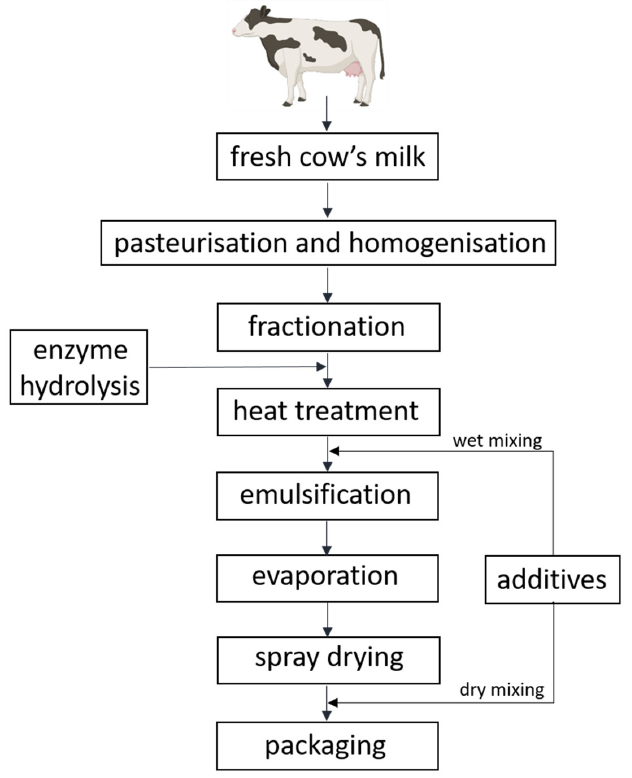
Figure 2. Example of main steps involved in the manufacturing of powdered infant formula. Fresh cow’s milk is at first standardised by means of pasteurisation and homogenisation. Further, milk proteins are going through fractionation, heat treatment, mixing, emulsification, evaporation, spray drying, and packaging. Additives are added and mixed with the protein fraction by means of wet or dry mixing. If wet mixing is applied, additives are added in a liquid form to a liquid protein fraction and together undergo emulsification, evaporation, spray drying, and finally infant formula powder packaging. If dry mixing is applied, the same steps are applied with the exception of additives being mixed with proteins in powdered form after spray drying. Additionally, if an infant formula is produced to be used in CMA management, enzyme hydrolysis of proteins is applied after the fractionation step. Picture of the cow is from BioRender.com.